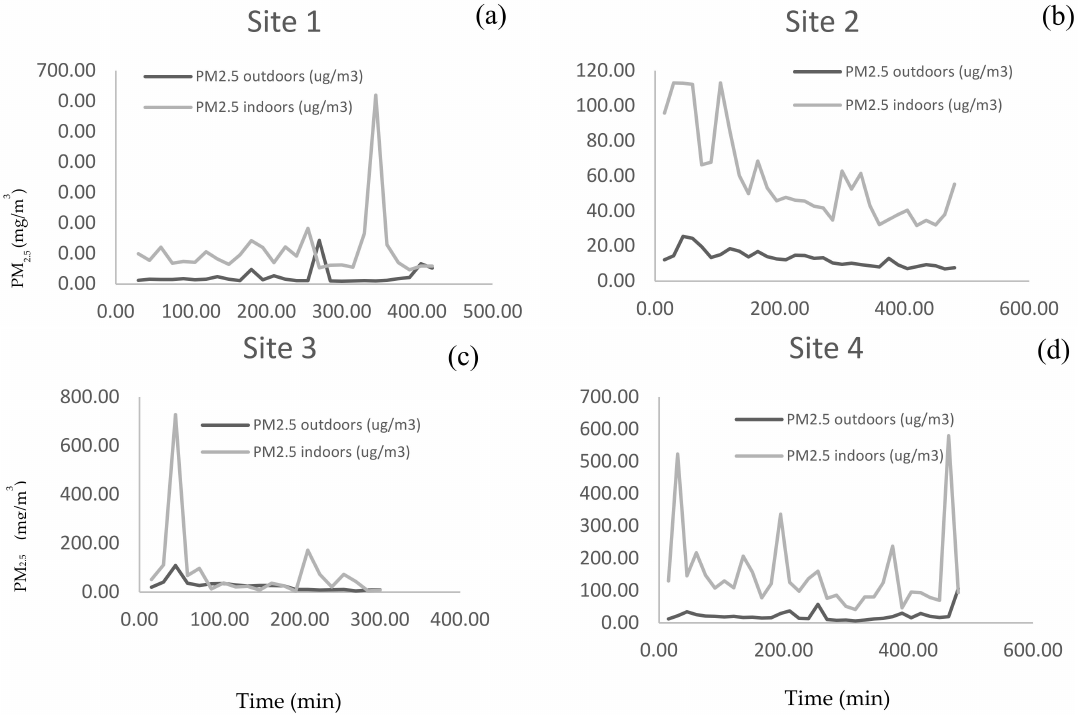
Figure 2. A comparison of time series record of 15-min average indoor and outdoor PM 2.5